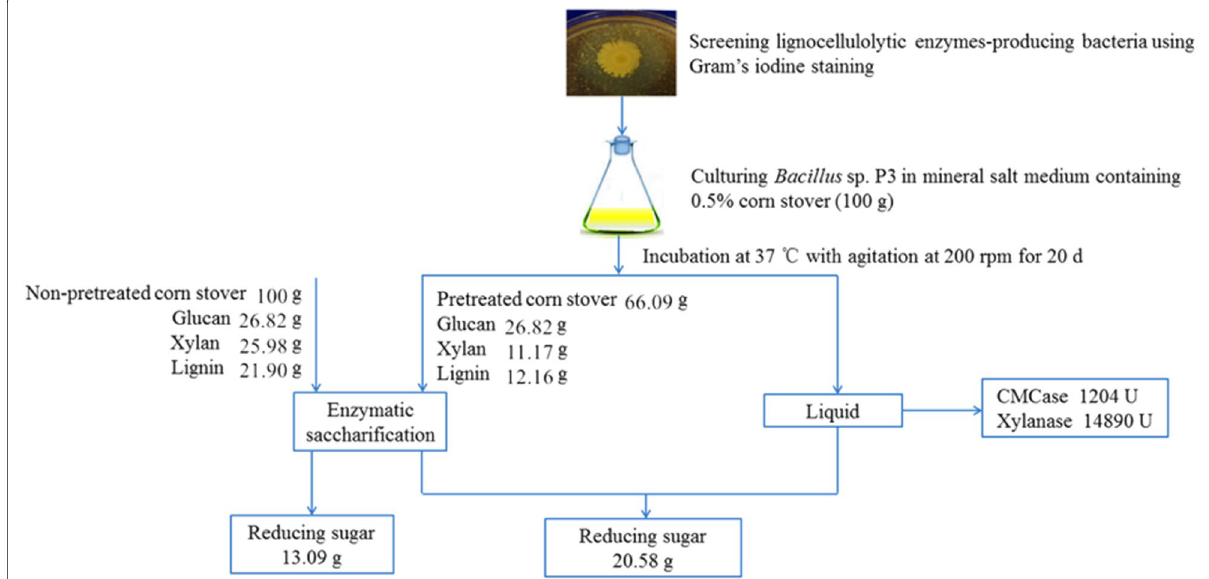
Fig. 6 Flowchart summarizing the effects of Bacillus sp. P3 on cellulolytic enzymes production, xylan decomposition, lignin removal and enzymatic saccharification of corn